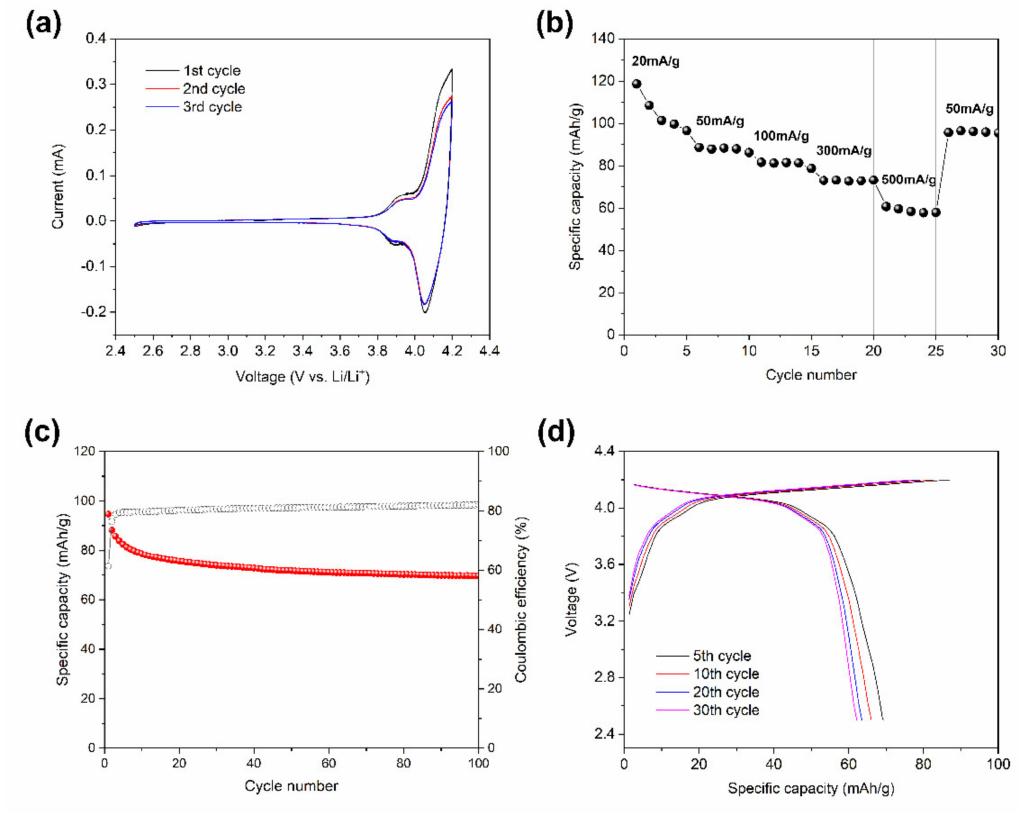
Figure 6. ( a ) Cyclic voltammogram of PTPA cathode at scan rate of 0.1 mV/s. ( b ) Rate capability of PTPA cathode at various current densities of 20, 50, 100, 300, 500 mA/g, and recovery step at current rate of 50 mA/g. ( c ) Long cycle test of PTPA cathode, at a current rate of 50 mA/g, between 2.5–4.2 V; specific capacity (red) and coulombic efficiency (black). ( d ) Corresponding charge-discharge voltage plots of PTPA cathode at 5th, 10th, 20th, and 30th